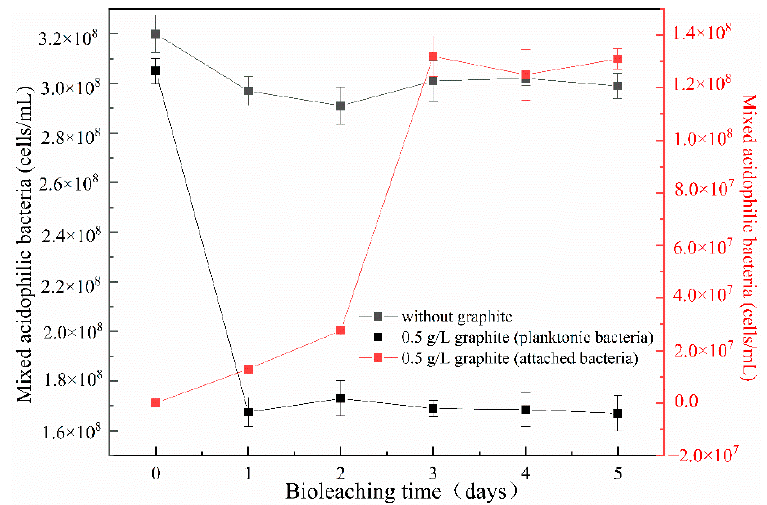
Figure 4. Planktonic- and attached-cell concentration (mean ± SD) during bacterial growth with graphite addition (other conditions: 1.6 pH, 0.5 g/L graphite, 45 °C, 170 rpm).